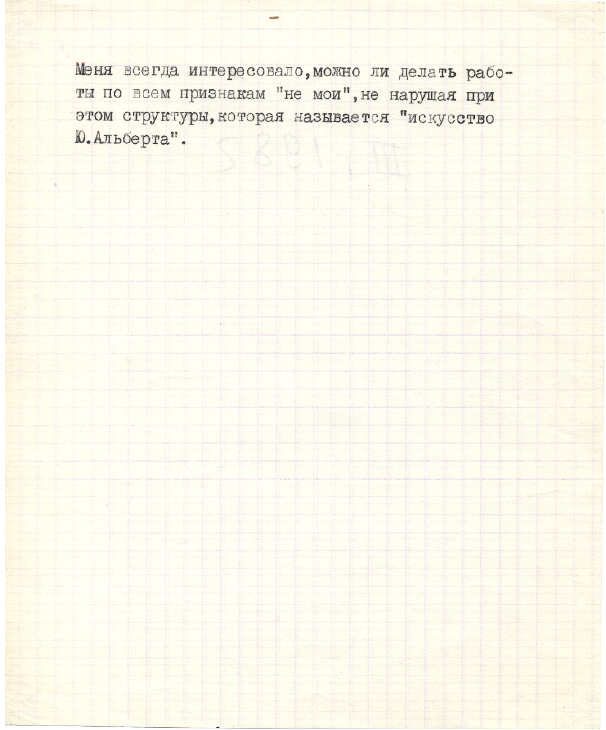
Figure 19. Albert. Autoseries III. 1982. Paper. 20.2 cm × 16.5 cm. Courtesy of the artist. Collaboration and materiality play significant roles in Eight Assignments for N.